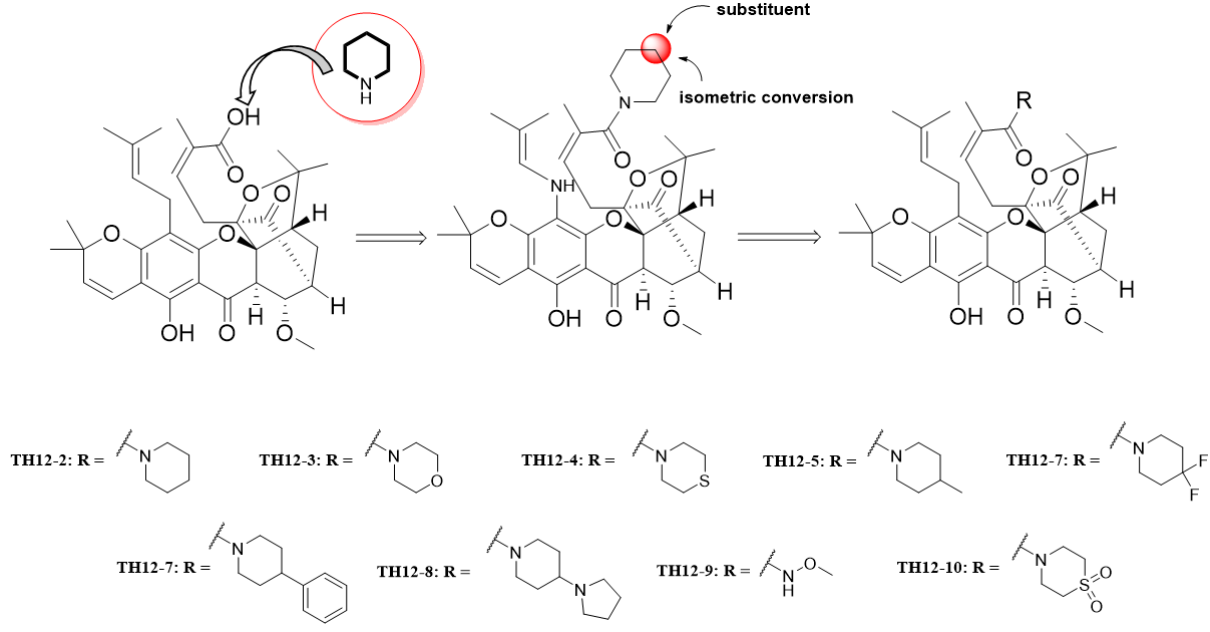
Figure 2. Design strategy of title compounds.